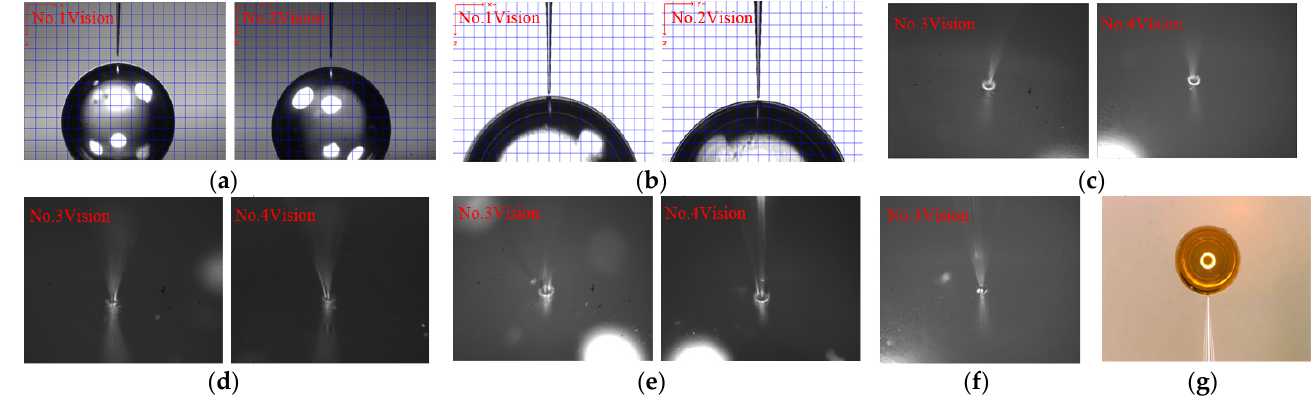
Figure 12. Images in assembly process: ( a ) before alignment; ( b ) after attitude alignment; ( c ) after position alignment; ( d ) after inserting; ( e ) dispensing needle is controlled; ( f ) after dispensing; ( g ) a CFTA